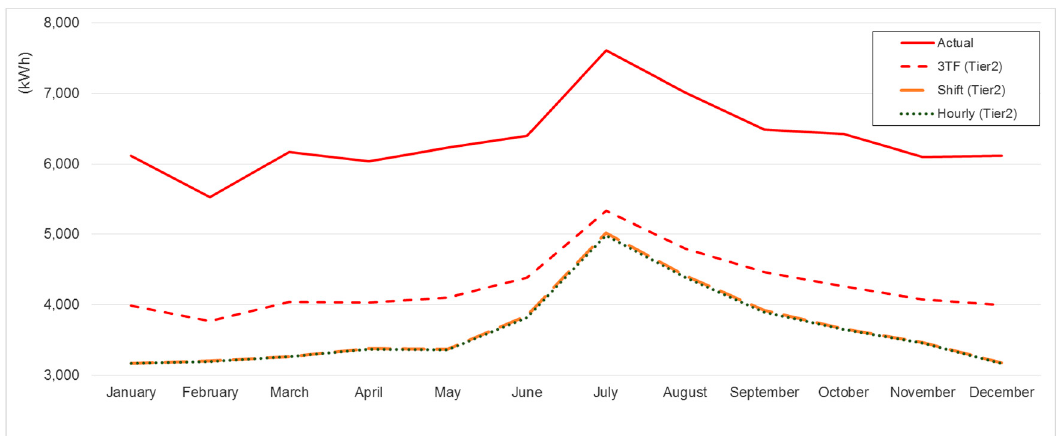
Figure 7. Monthly energy losses on Sec SS 3 with the three control systems of the number of transformers connected, considering that transformers fulfilled TIER1. Energies 2018 , 11 , x FOR PEER REVIEW Table 7. Percentage of losses with new transformers compared to the current connection (%).